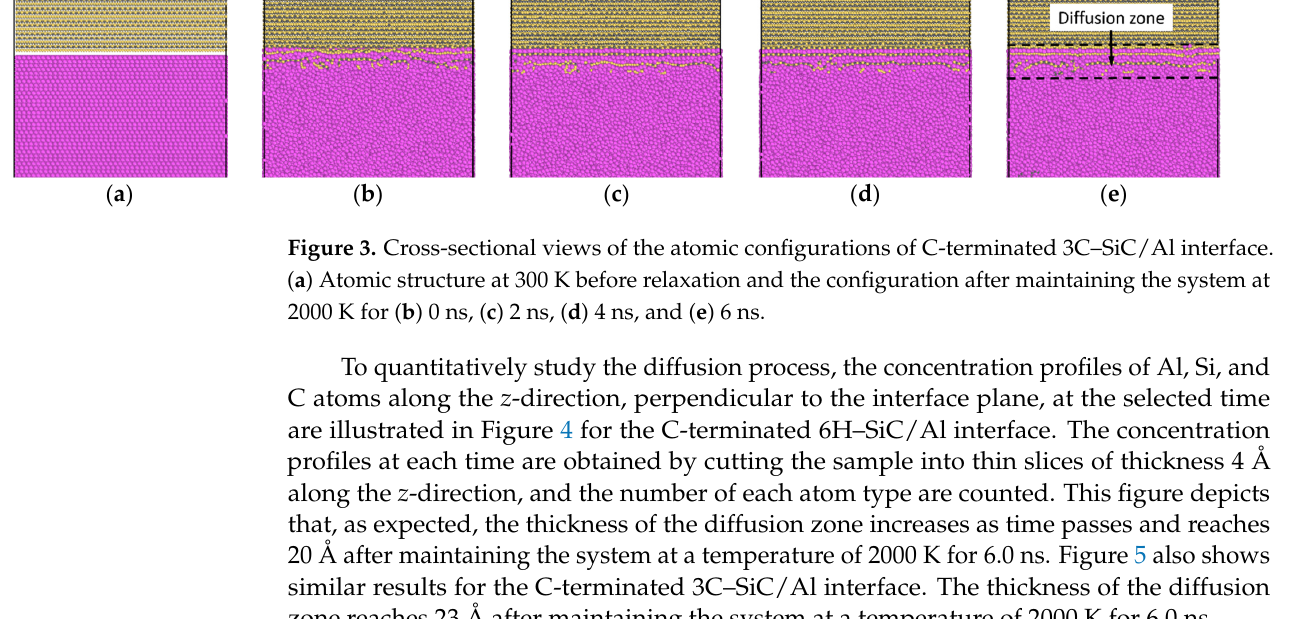
3C–SiC/Al interface when the system is heated up to 2000 K and maintained at this tem-